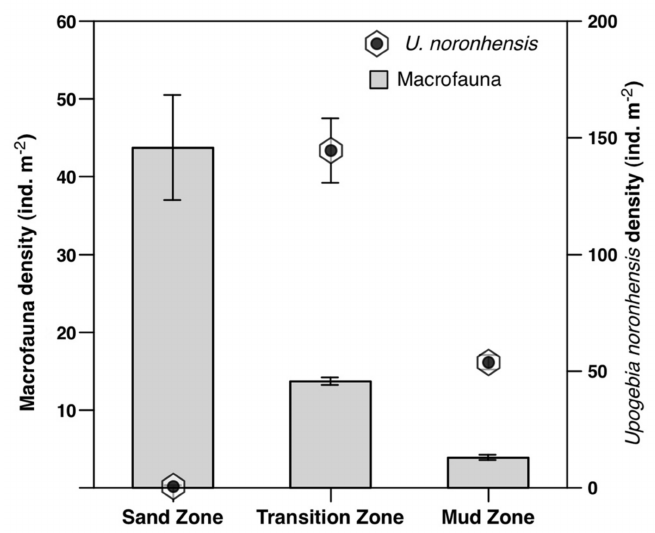
Figure 3. Macroinfaunal (n = 3, per zone) and U. noronhensis (n = 9, per zone) densities (ind. m − 2 ) in the Table